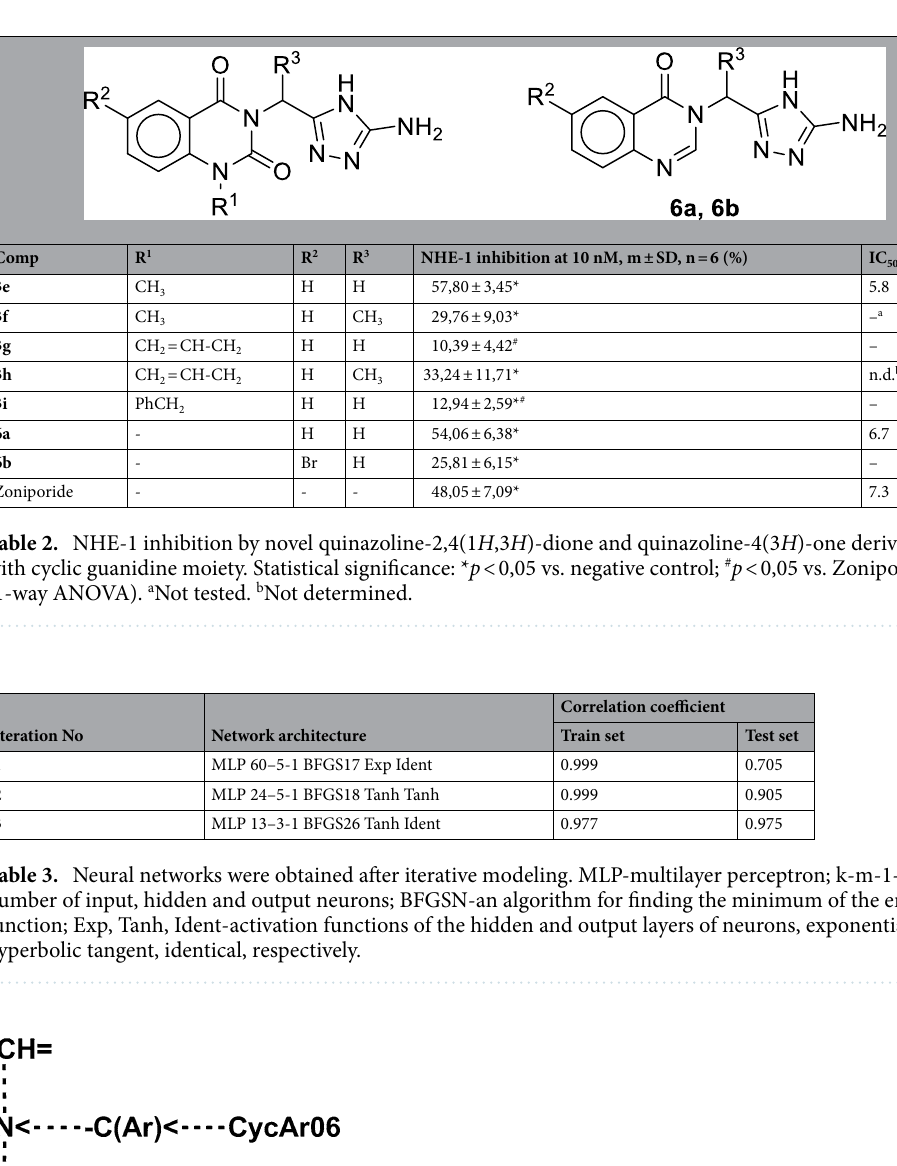
Figure 3. Pharmacophore that defines a high level of NHE-1-inhibitory activity of novel